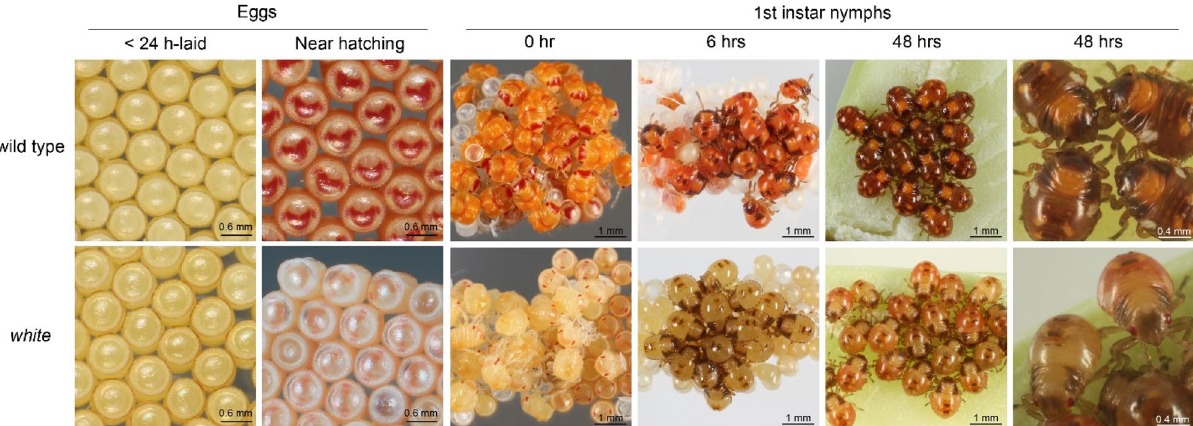
Figure 3. Phenotypes observed in the progeny of white dsRNA treated SGSB adult females relative to a wild type progeny of GFP dsRNA-treated